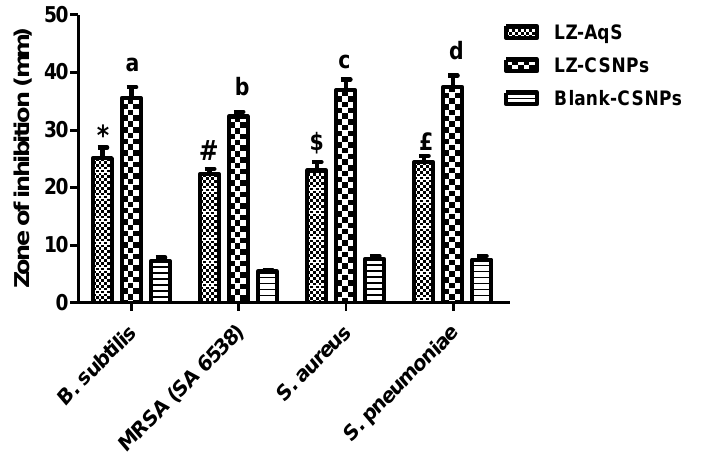
Figure 4. Antimicrobial activity of LZ–containing products as compared to the blank CSNPs against Bacillus subtilis , MRSA (SA–6538), Staphylococcus aureus, and Streptococcus pneumoniae. Results were represented as mean of three measurements with standard deviation (Mean ± SD). “a” p < 0.05, LZ –